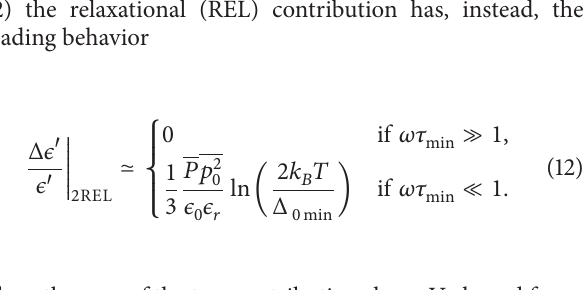
1 : 1 slope ratio. Figure 7 (main) shows this phenomenon